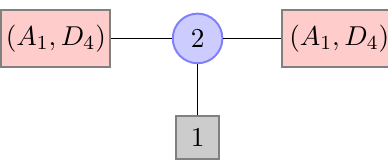
Figure 1 . A quiver diagram describing a weak coupling limit of the ( A 3 , A 3 )